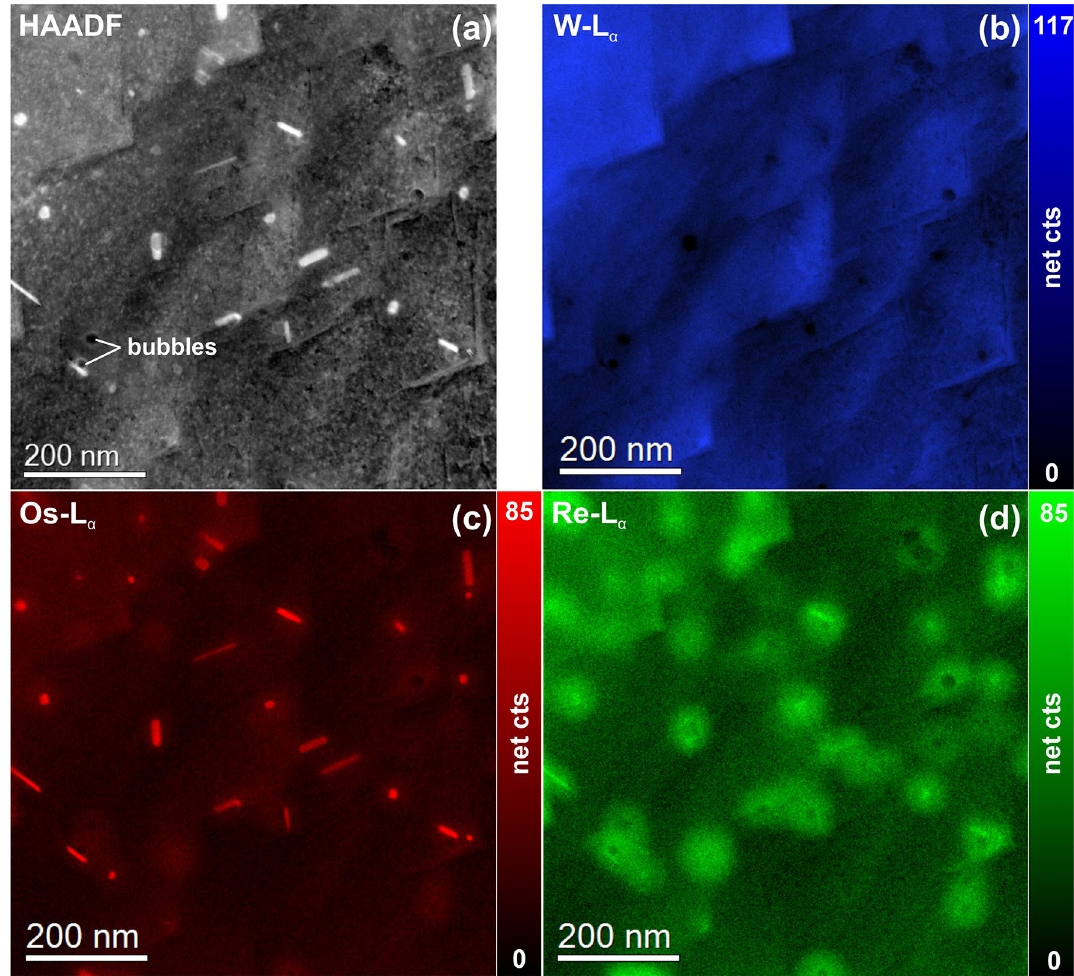
Figure 4. STEM-EDX spectrum image of a representative region in a neutron-irradiated W specimen. ( a ) STEM-HAADF image. Elemental maps of ( b ) W, ( c ) Os, and ( d ) Re display the location of elements with respect to the sample morphology. The tile-like structure in the HAADF image and the W map is surface topography due to flash